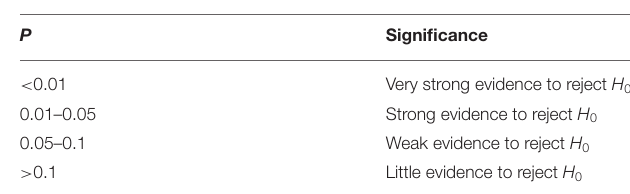
TABLE 1 | P -value